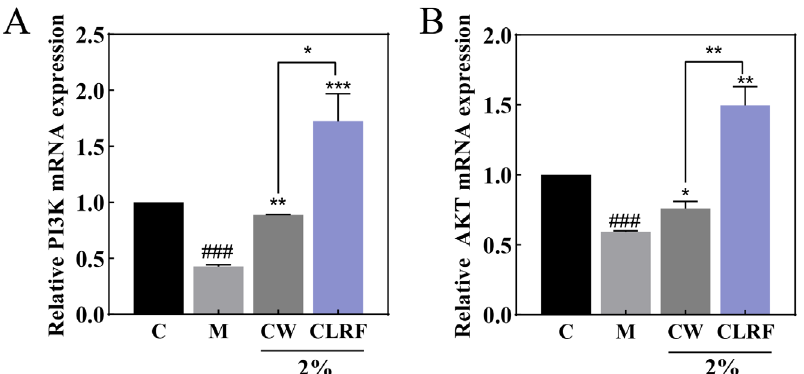
Figure 5. Expression of PI3K/AKT pathway genes in cells at 2% concentration of CLRF and CW: ( A ) Relative expression of PI3K in HSF cells; ( B ) Relative expression of AKT mRNA in HSF cells. CW: Coix seed water extract; CLRF: Coix seed Lactobacillus reuteri fermentation broth; C: control group; M: H 2 O 2 damage model group. Each value is expressed as mean ± SD ( n = 3). (*: p < 0.05, **: p < 0.01, ***: p < 0.001 versus model group, ###: p < 0.001, versus control group).